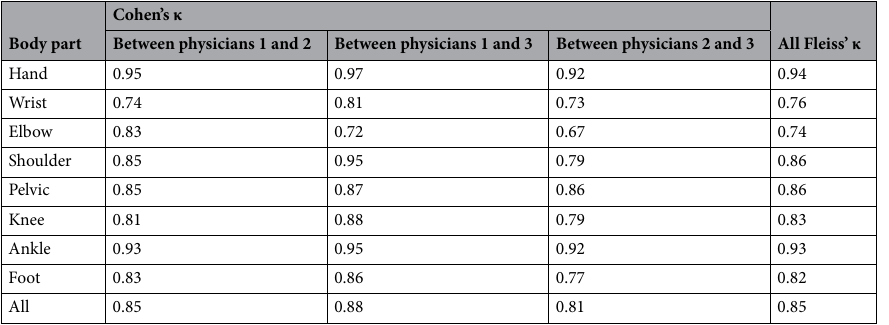
Table 6. Reliability of the gold standards for the fracture dataset. The guidelines of Fleiss and colleagues characteristic κ values of more than 0.75 were set as excellent agreement, 0.40–0.75 as fair to good agreement, and less than 0.40 as poor agreement beyond chance.